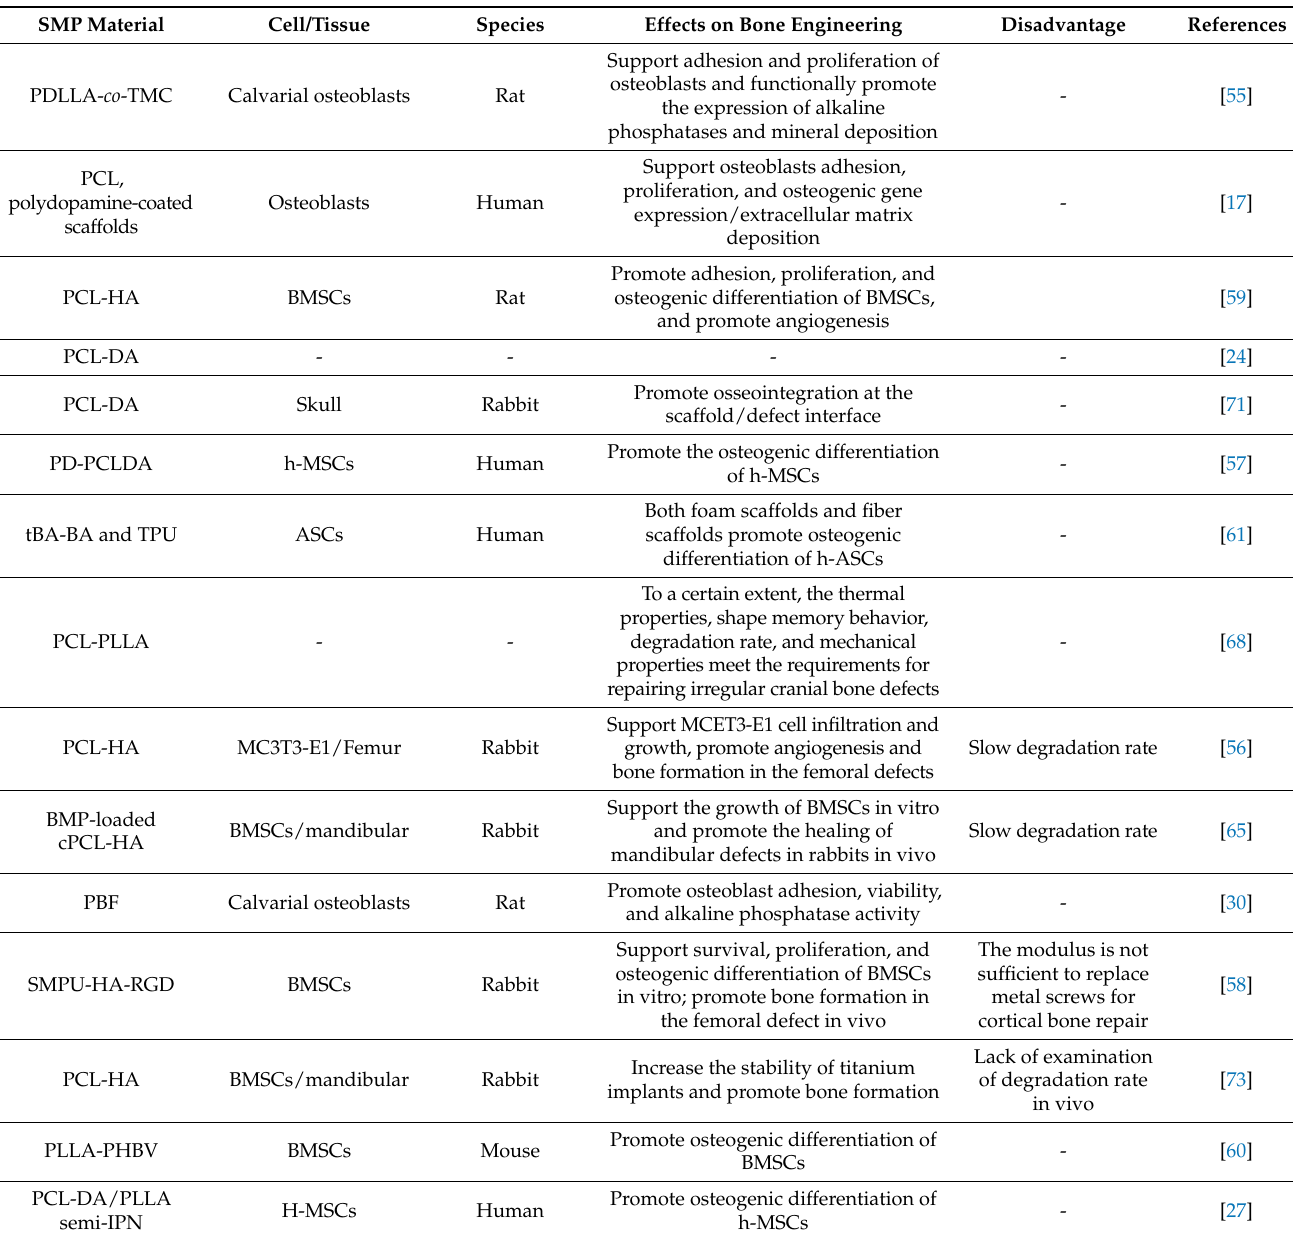
Table 1. Application of SMPs in bone tissue